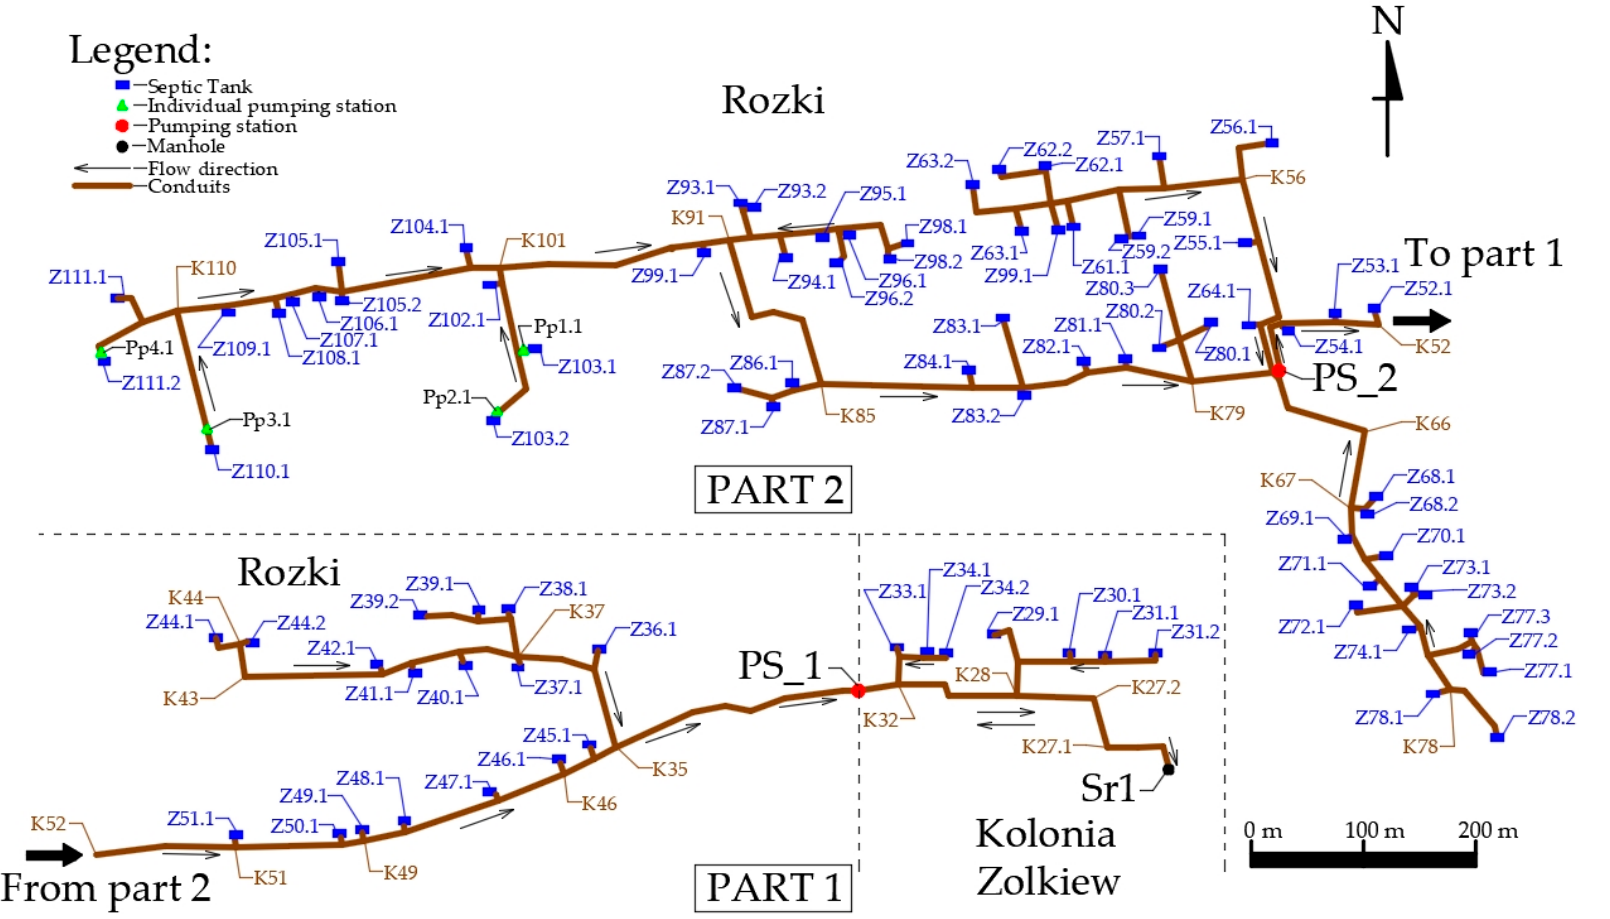
Figure 1. Scheme of the SDGS system in Rozki and Kolonia Zolkiew.